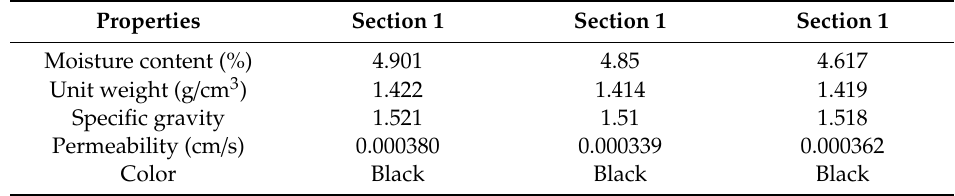
Figure 3. Location coal seam No 14-5 (Khe cham III coal mine, Quangninh, Vietnam). Table 1. General characteristics of the coal